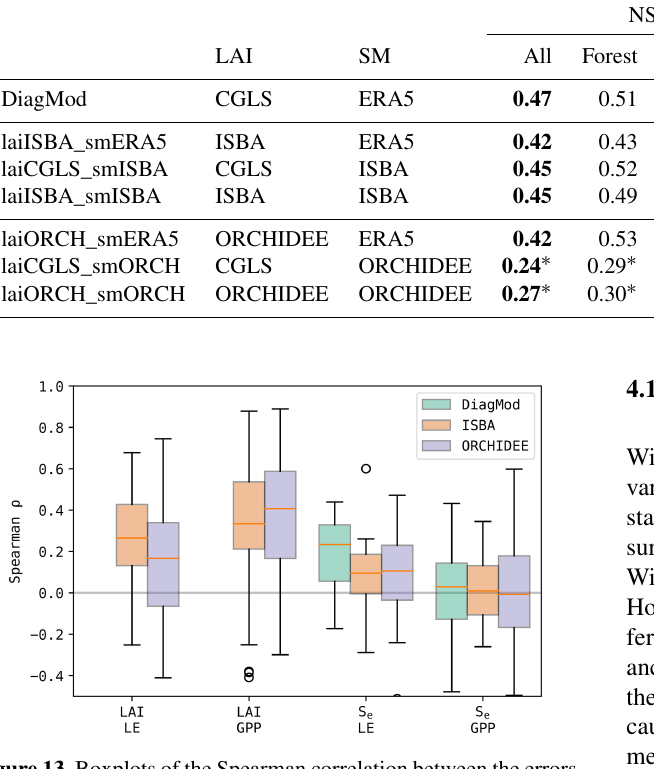
Figure 13. Boxplots of the Spearman correlation between the errors in the state variables ( S e and LAI) and the fluxes ( LE and GPP) at all test